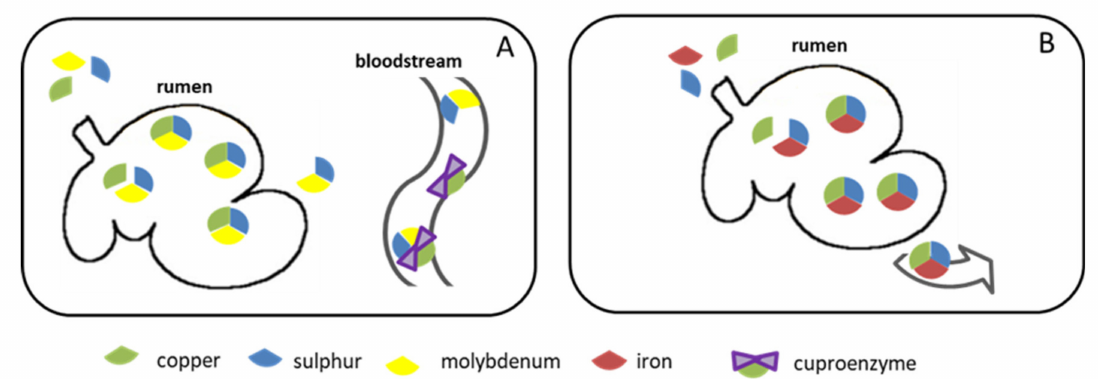
Figure 2. Interactions between copper and its antagonists. ( A ) In the rumen, molybdenum and sulphur combine to form thiomolybdates (MoS4), which display a high a ffi nity for copper and will bind any copper present. If there is not enough copper in the rumen, MoS4 moves into the bloodstream and binds to cuproenzymes thus blocking them. ( B ) Iron and sulphur can also combine with copper in the rumen to create a stable, non-absorbable